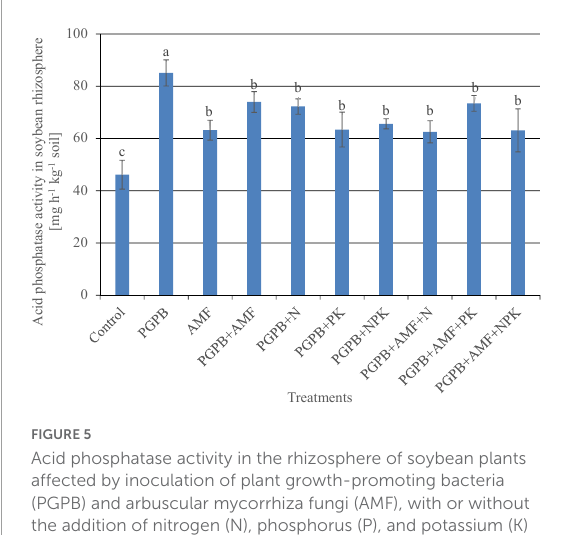
FIGURE5 Acid phosphatase activity in the rhizosphere of soybean plants affected by inoculation of plant growth-promoting bacteria (PGPB) and arbuscular mycorrhiza fungi (AMF), with or without the addition of nitrogen (N), phosphorus (P), and potassium (K) fertilizers. Data (Mean ± SD) with different letters are significantly different (Tukey’s HSD, p <